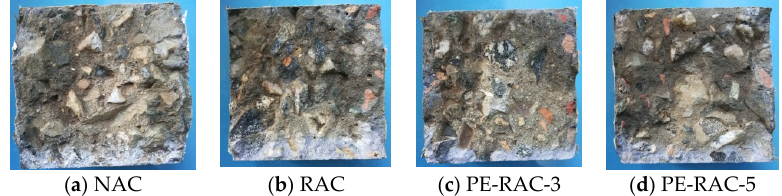
Figure 4. Erosion map of salt spray with different fiber content (14 d).